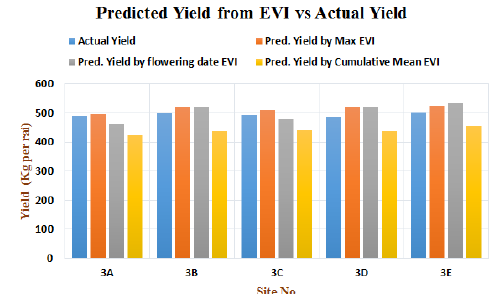
Figure 13: Actual yield and predicted yield from EVI by different method in Site